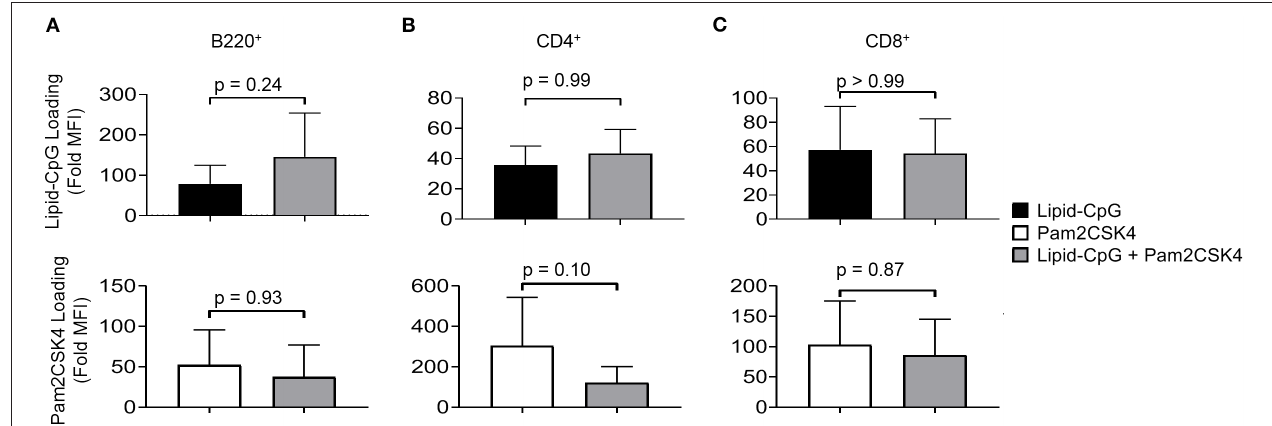
FIGURE 2 | Lipid-tailed ligands efficiently depot alone and together into resting B and T cells. Fluorescently labeled lipid-CpG or biotinylated Pam2CSK4 was incubated either separately or together with splenic immune cells at 5 µ M or 10 µ g/mL, respectively, for 1h at 37 ◦ C. Splenic immune cells were gated by lineage markers to analyze lipid-CpG ( top row ) and Pam2CSK4 ( bottom row ) depoting in 3 cell types: (A) B220 + B cells, (B) CD4 + T cells, and (C) CD8 + T cells. Loading was calculated as the fold increase of sample median fluorescent intensity (MFI) normalized to non-depoted cells for each ligand. p -values between indicated conditions for each panel (top and bottom) were determined by one-way ANOVA with Sidak’s method for multiple comparisons correction. Data showed m ± s.d. ( n = 4 independent samples).